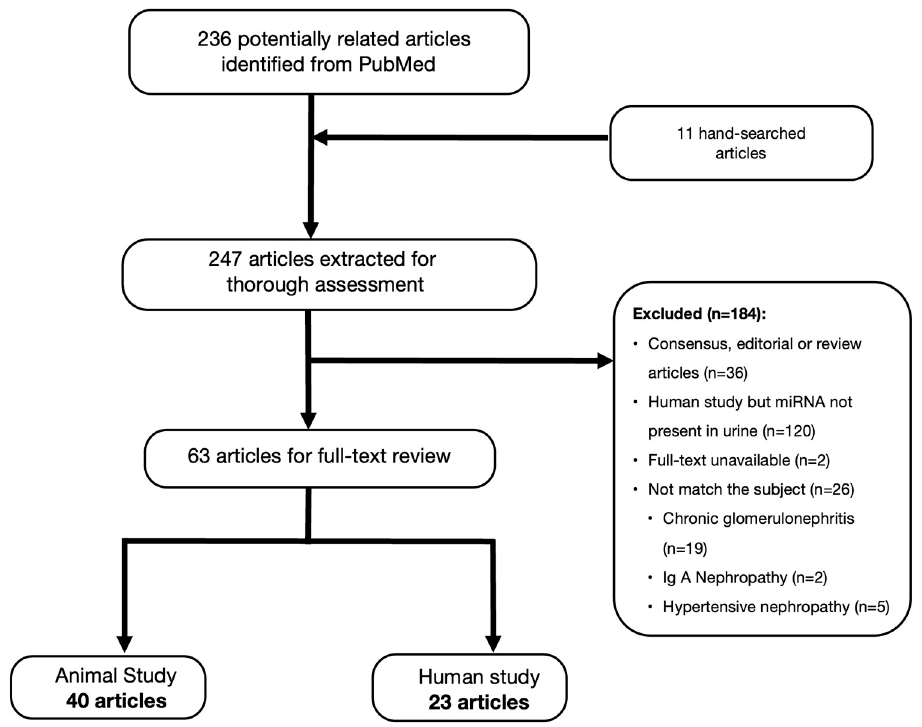
Figure 1. Flow chart of literature search and selection.